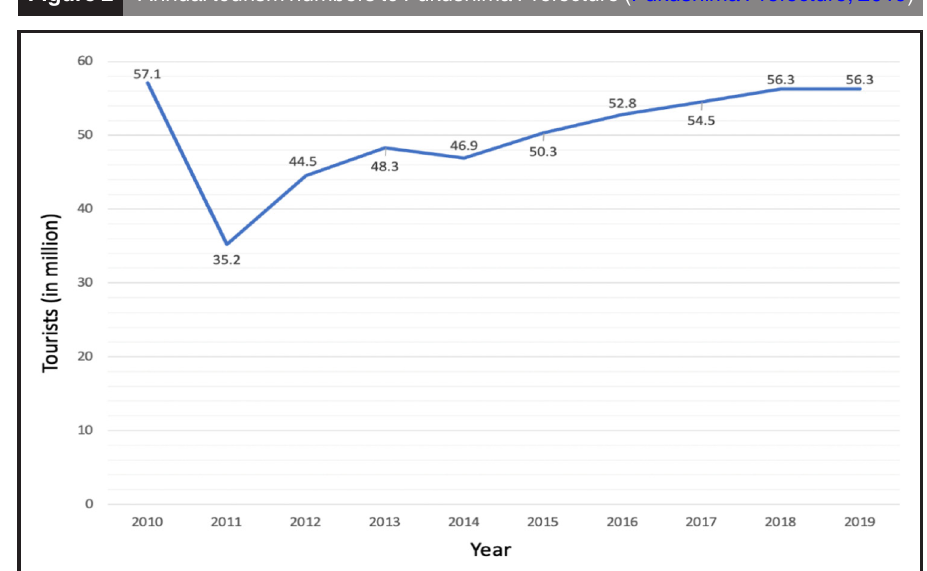
Figure 2 Annual tourism numbers to Fukushima Prefecture (Fukushima Prefecture,